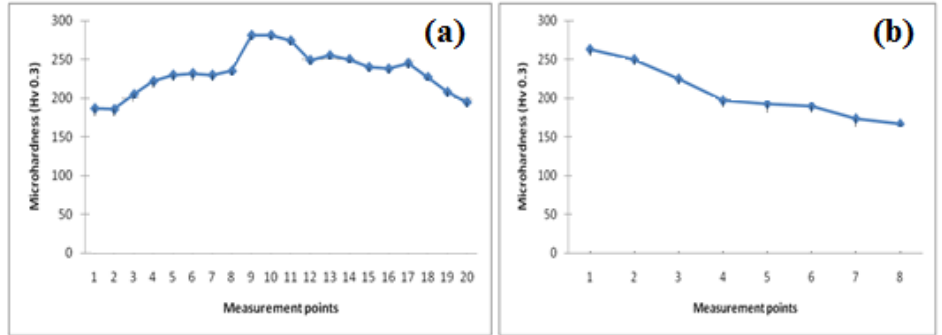
Figure 6. Microhardness test results of sample S1 ( a ) horizontal and ( b )